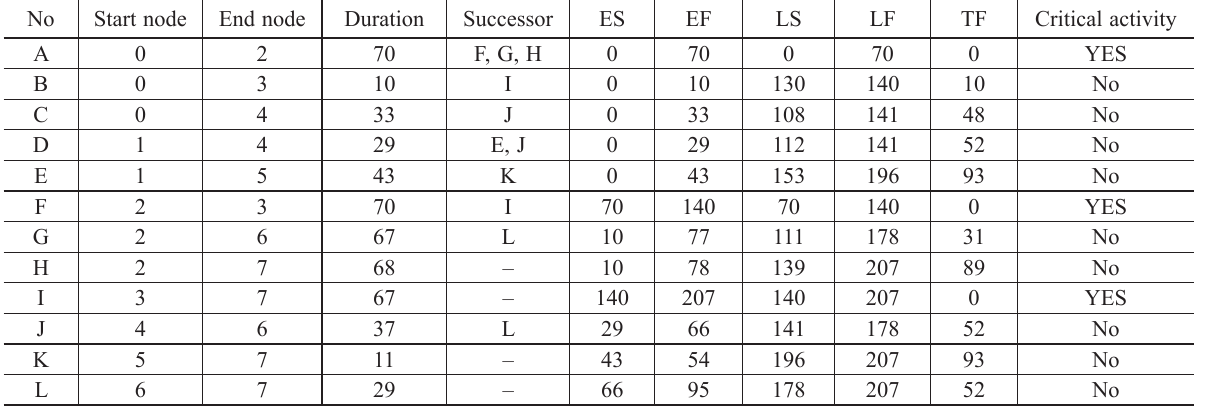
Table 6. The identified network topology parameters q 0 = 0.3 assist the selection of path based on the probability or random selection ρ = 0.5 determine the level of evaporation of pheromone concentration for local update α = 1.0